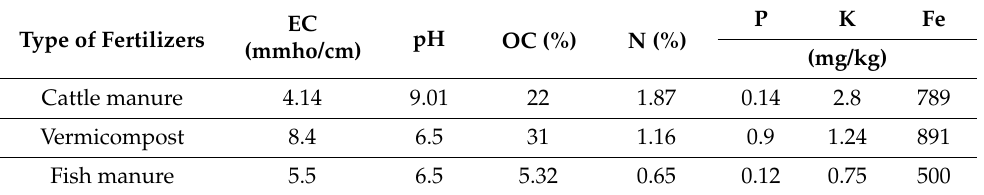
Table 2. Physical and chemical properties of fertilizers used in the test. Type of Fertilizers